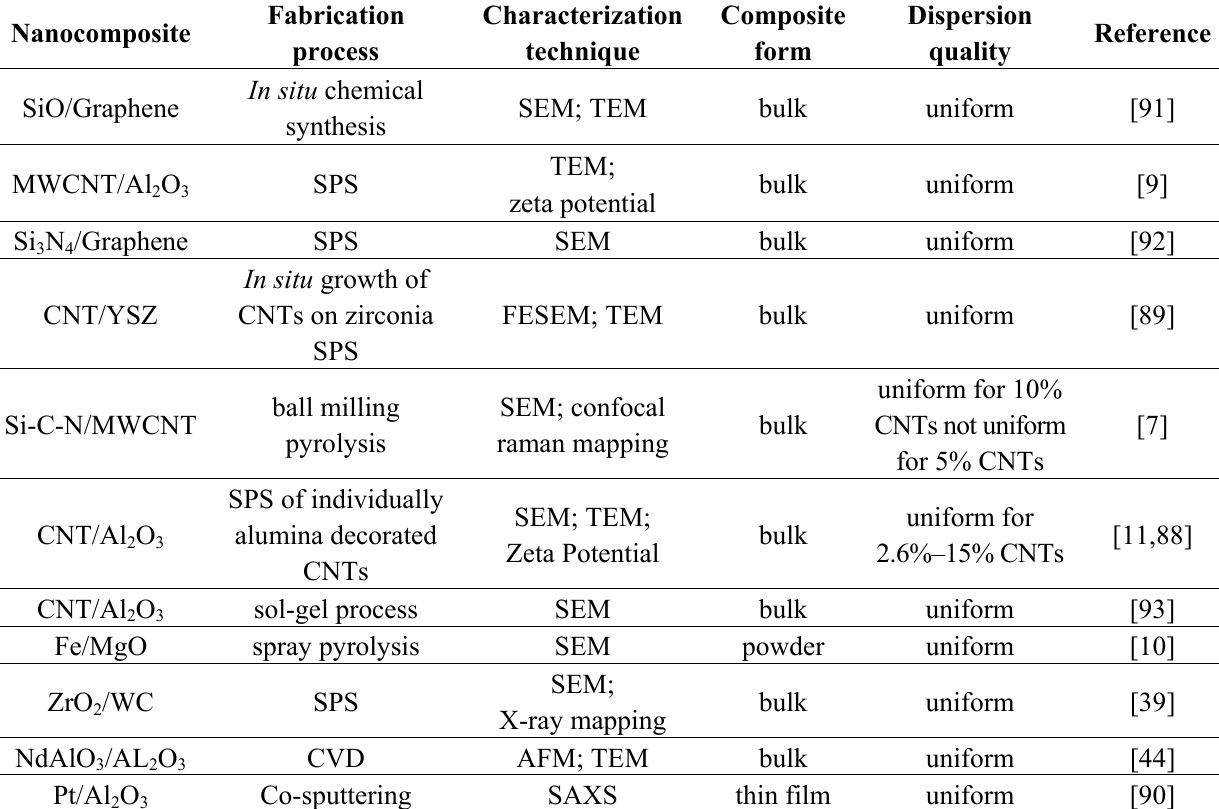
Table 3. Extent of reinforcement dispersion in selected